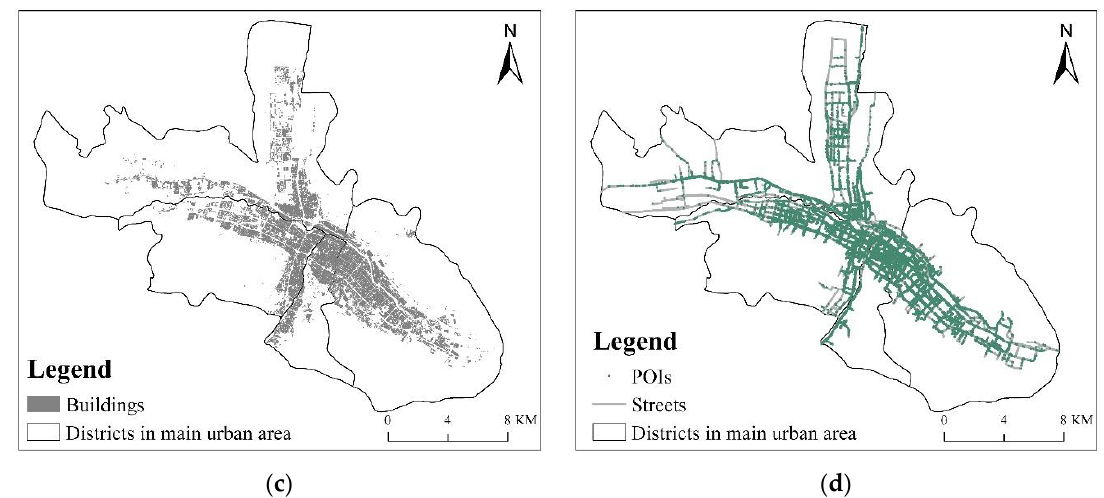
Figure 2. Spatial distribution of the elements from the four data sources. ( a ) Main roads; ( b ) Base station; ( c ) Buildings; ( d ) points of interest (POIs).